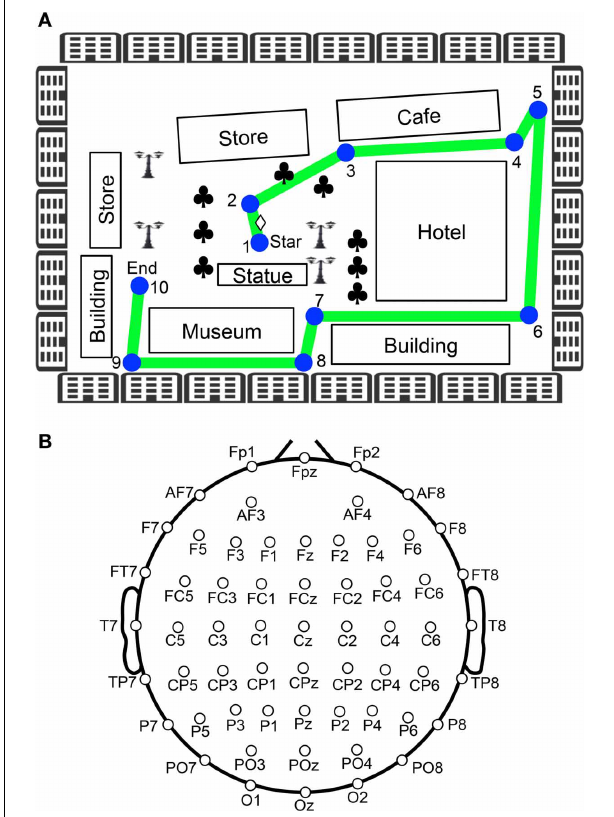
FIGURE 1 | Experimental paradigm of the virtual navigation task. (A) Navigation route in the virtual town. In the control phase, 10 spatial reference points (checkpoints) were blue-colored circles labeled with numbers, which were connected by a green line. When the task was initiated subjects were always located at the position indicated by a diamond between checkpoints 1 and 2. Subjects were then required to sequentially trace the checkpoints from 1 to 10. In the test phase, the subjects were required to perform the same task three times, except that the 10 circular checkpoints and green line were made invisible in the virtual town. Subjects performed the task while undergoing EEG recording. Clovers indicate trees. (B) Arrangement of the